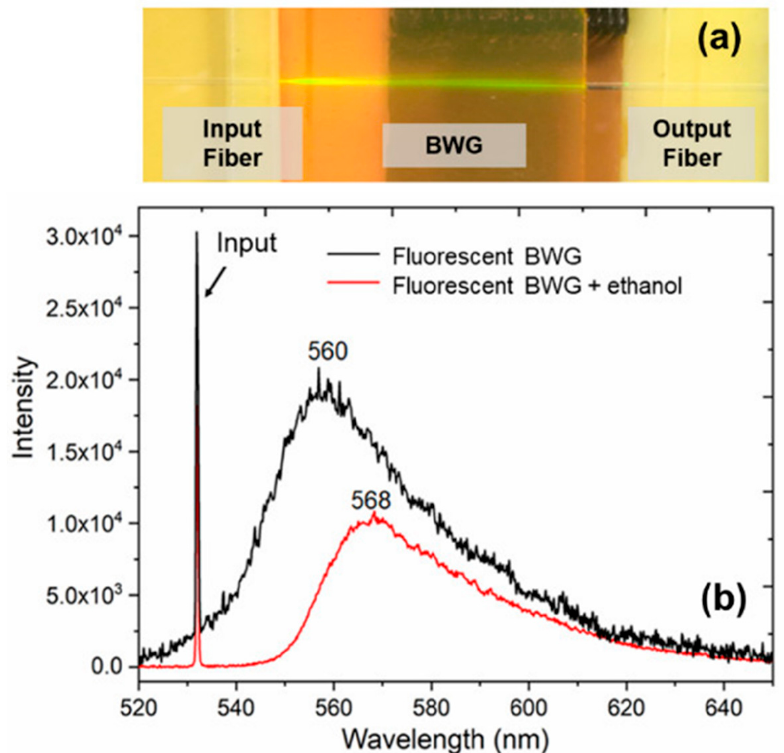
Figure 6. The image of laser radiation coupling into the BWG by the fiber–sample–fiber connection ( a ). The spectra curves of laser radiation transmitted through the BWG ( b ): black curve corresponds to the signal captured from the BWG in PG impregnated with rhodamine 6G and dried in the furnace (100 °C, 15 min), while the red curve demonstrates the same BWG after ethanol molecules (100%) captured by the nanoporous framework. Input radiation is 531.7 nm of the diode laser with power ~1.5 mW.